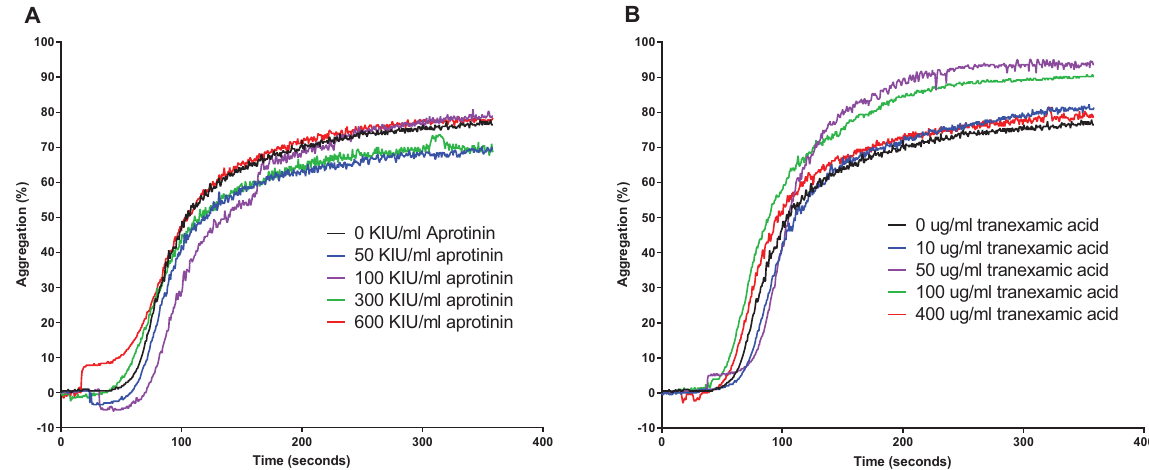
Fig. 9 Effects of aprotinin and TXA on collagen-induced platelet aggregation. Aprotinin (panel A), or tranexamic acid (panel B) were added in increasing concentrations to human platelet-rich plasma after which platelet aggregation was initiated by addition of 2 ug/ml of collagen. Shown is a representative example of experiments performed with three different